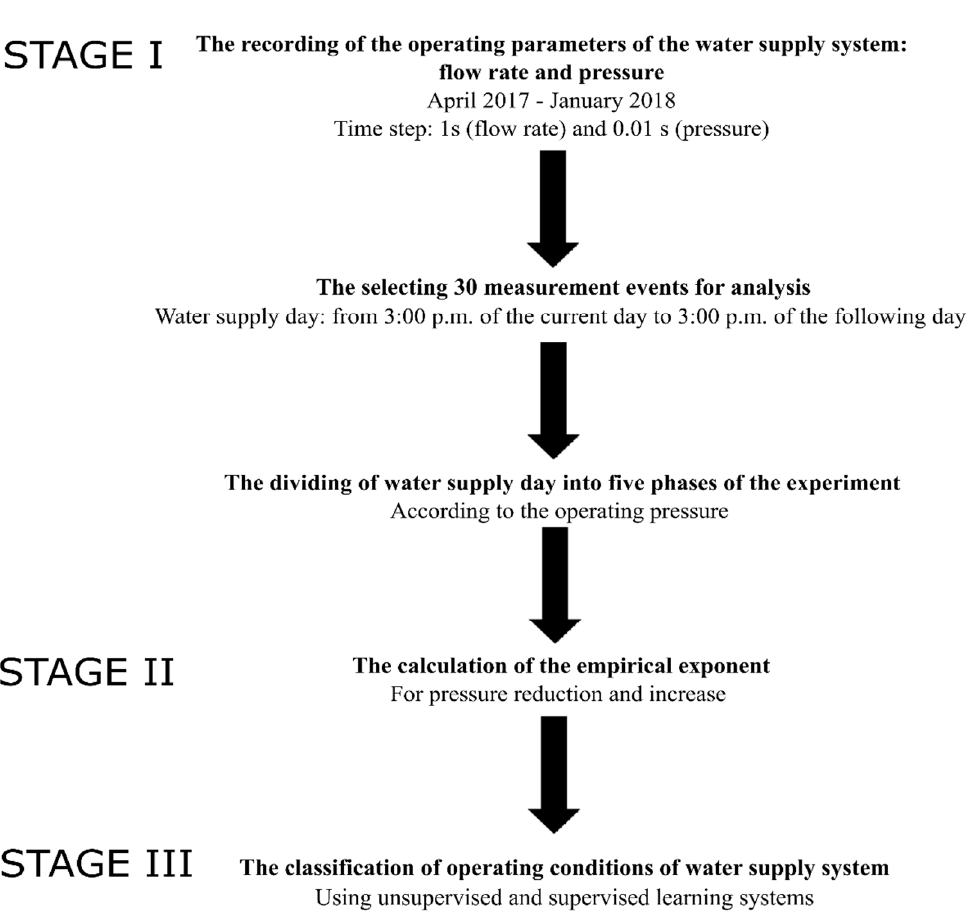
Figure 2. Research methodology scheme.